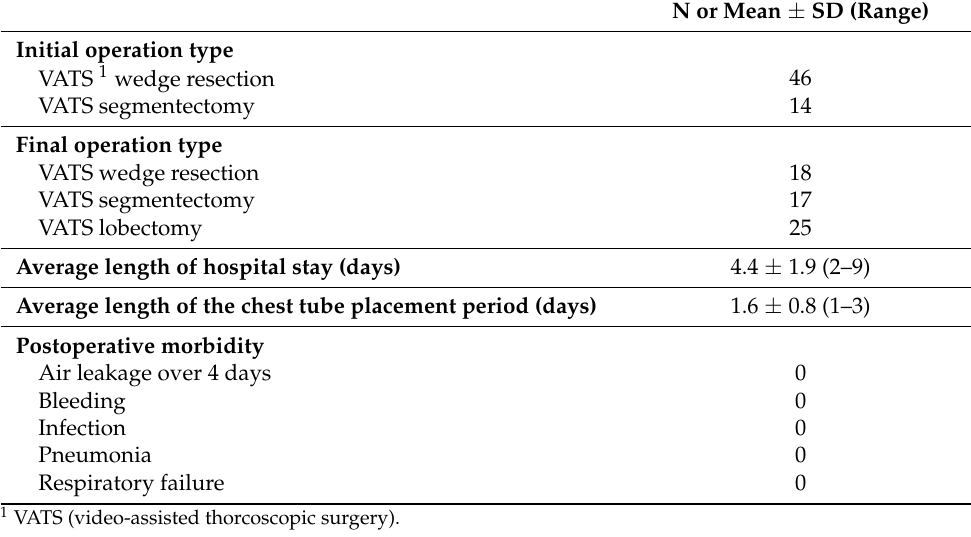
Table 3. Surgical approach and outcomes.